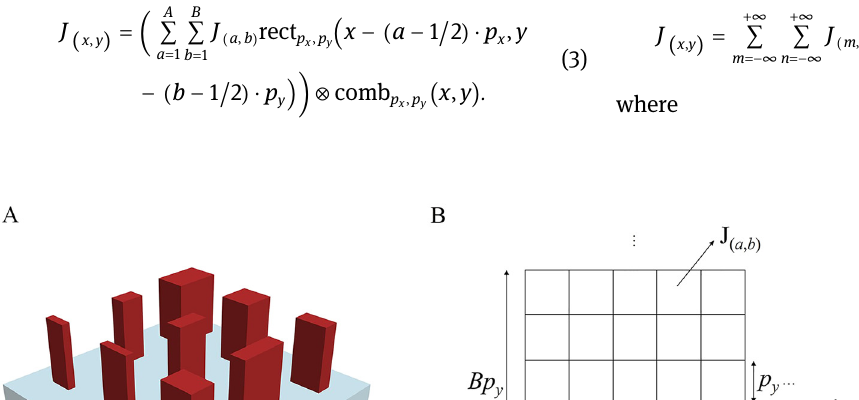
Figure 2: Basic structure of supercells of the beam deflection metasurfaces and simplified representation of the 2D grid of the metasurface grating structure. (A) Basic structure of the supercells. (B) Simplified representation of the 2D grid of the metasurface